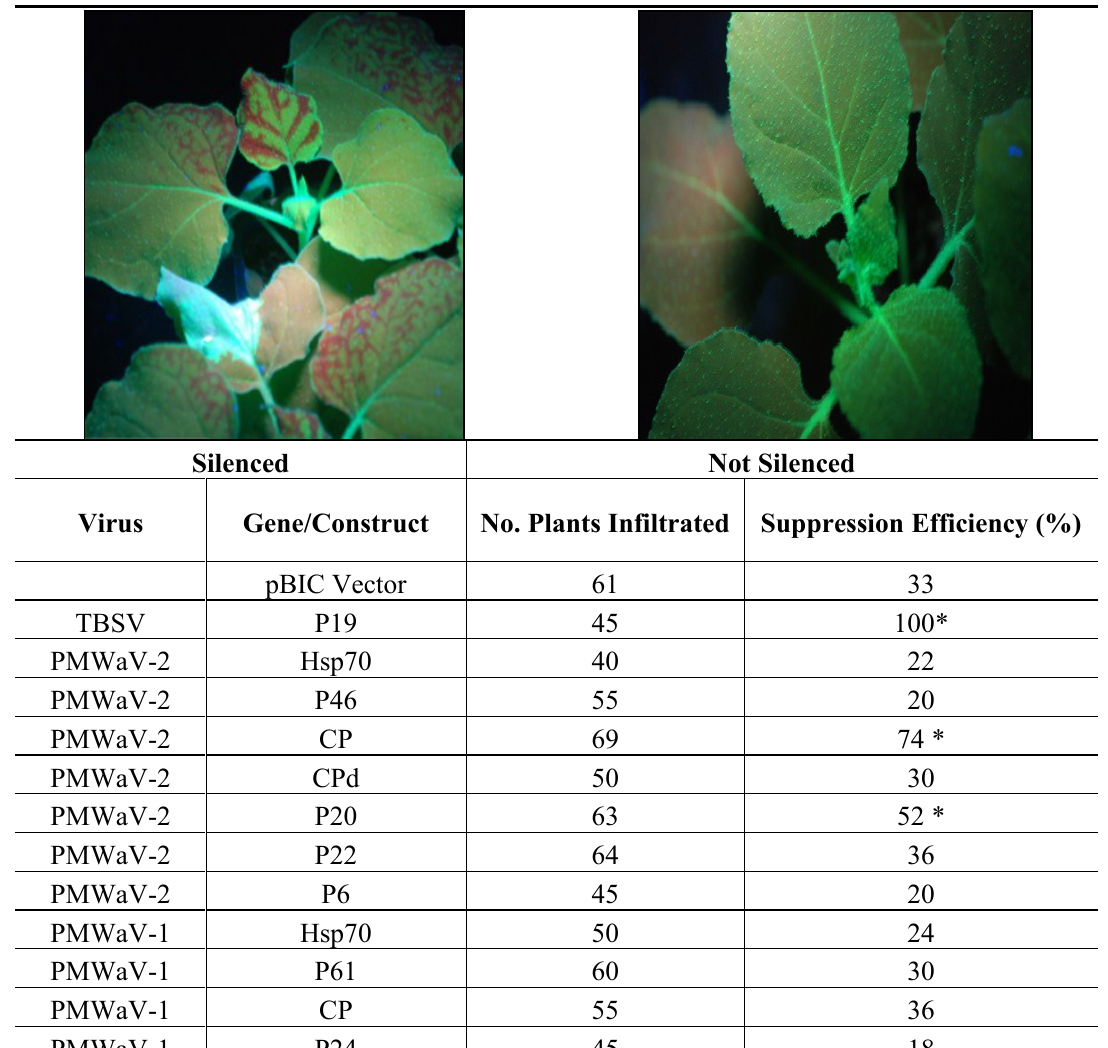
Table 2. Effect of PMWaVs ORFs on GFP-induced systemic silencing in transgenic N. benthamiana 16C plants. Agrobacterium carrying 35S-sGFP and individual